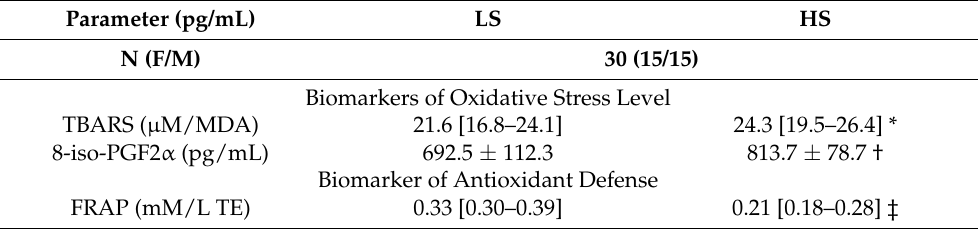
Table 3. Thiobarbituric acid reactive substances (TBARS), ferric-reducing ability of plasma (FRAP), and serum 8-iso prostaglandin F2 (8-iso-PGF2 α ) protein concentration responses to a 7-day high-salt diet in healthy young individuals.